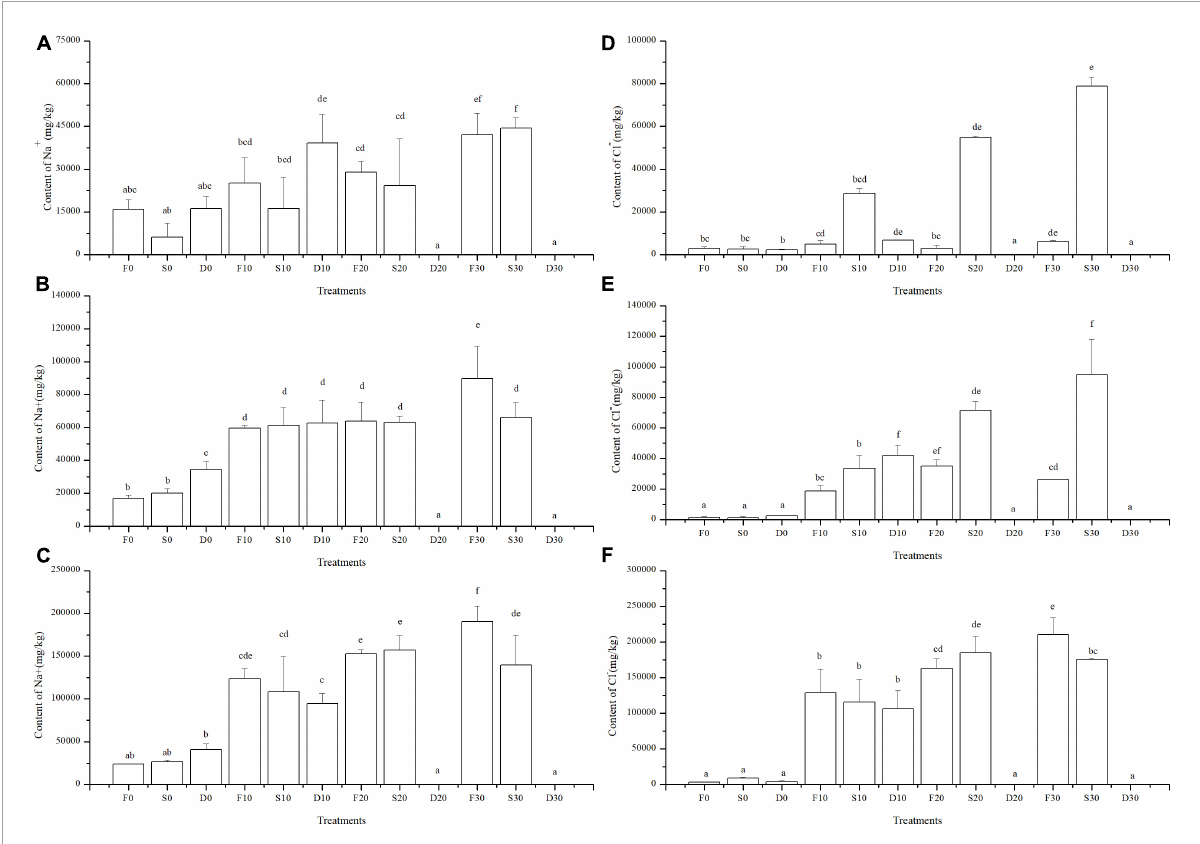
FIGURE3 Na + and Cl − distribution in each part of S. salsa subjected to salt and water treatments. (A) Content of Na + in the root, (B) Content of Na + in the stem, (C) Content of Na + in the root, (D) Content of Cl − in the root, (E) Content of Cl − in the stem, and (F) Content of Cl − in the root. The data was 0 in D20 and